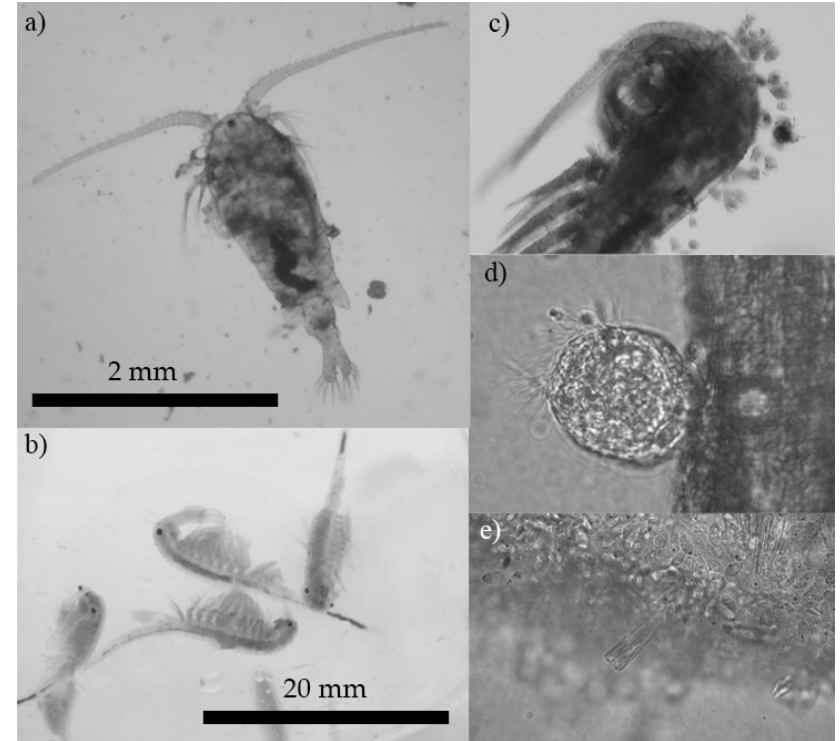
Figure 6. Microscope image showing two main metazoans present in Byers lakes. ( a ) Adult of the copepod Boeckella poppei; ( b ) Adults of the fairy shrimp Branchinecta gaini; ( c–e ) Pictures showing epibiotic ciliates and diatoms attached to the surface of Boeckella poppei . Note that the scale of the photographs is different. Bar scales are included to point out the different size of B. poppei and B. gaini . 8. Microbial Mats and Autotrophic Biofilms: Function and Diversity